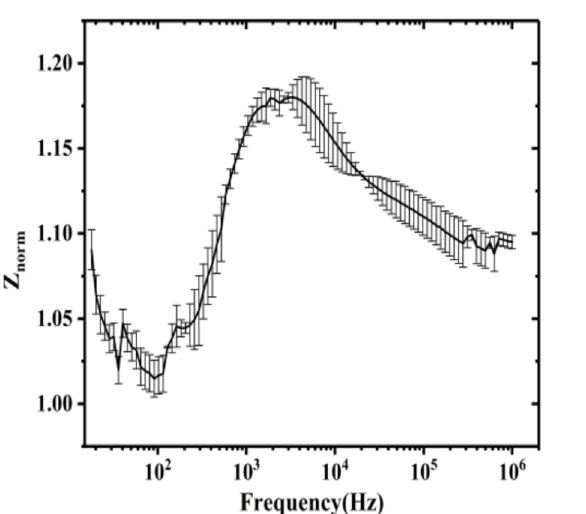
Figure 5. The normalized impedance of the electrodes with HeLa cells as a function of the detec- tion